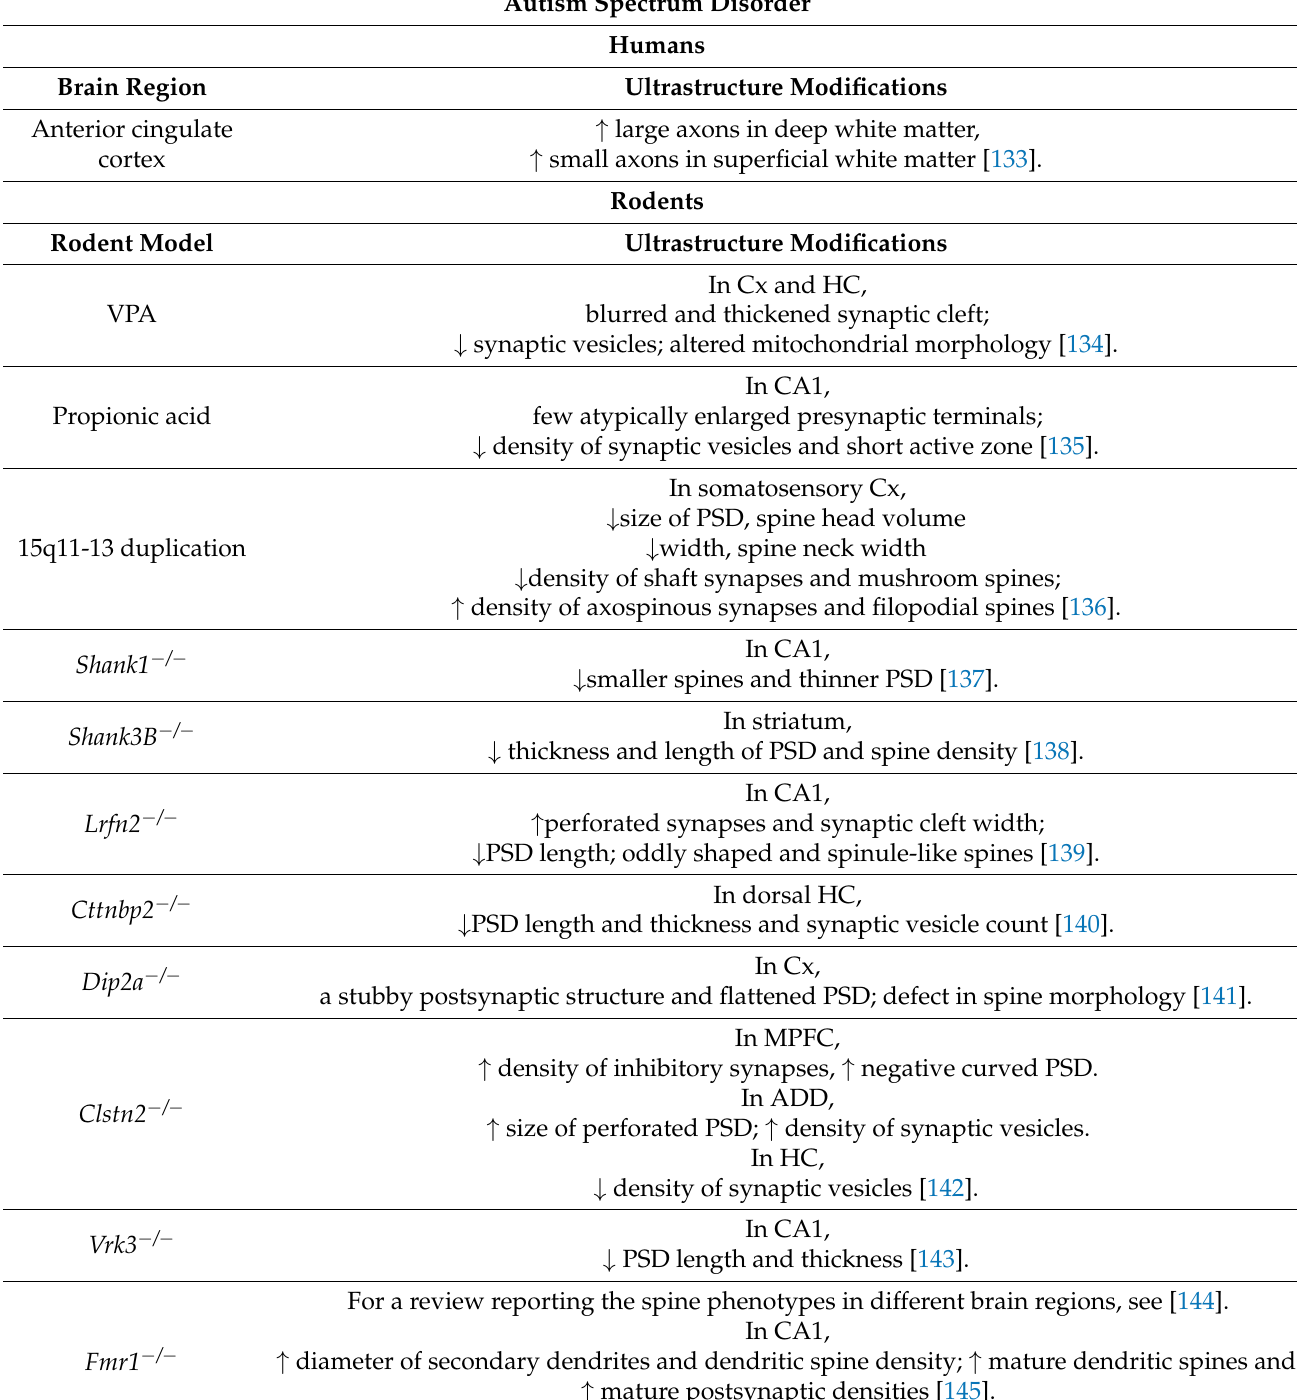
Table 2. Synaptic ultrastructural alterations in autism spectrum disorder. Different studies have assessed the synaptic ultrastructural changes of synaptic transmission in autism spectrum disorder. Only one has been done in postmortem human tissue. Rodent models are either chemical or genetic. The affected proteins are shown in Figure 1. ↑ stands for increased, ↓ stands for decreased. Full names of brain regions, genes, proteins, and drugs are as in the main text and abbreviation list. Cx: cortex, HC: hippocampus, MPFC: